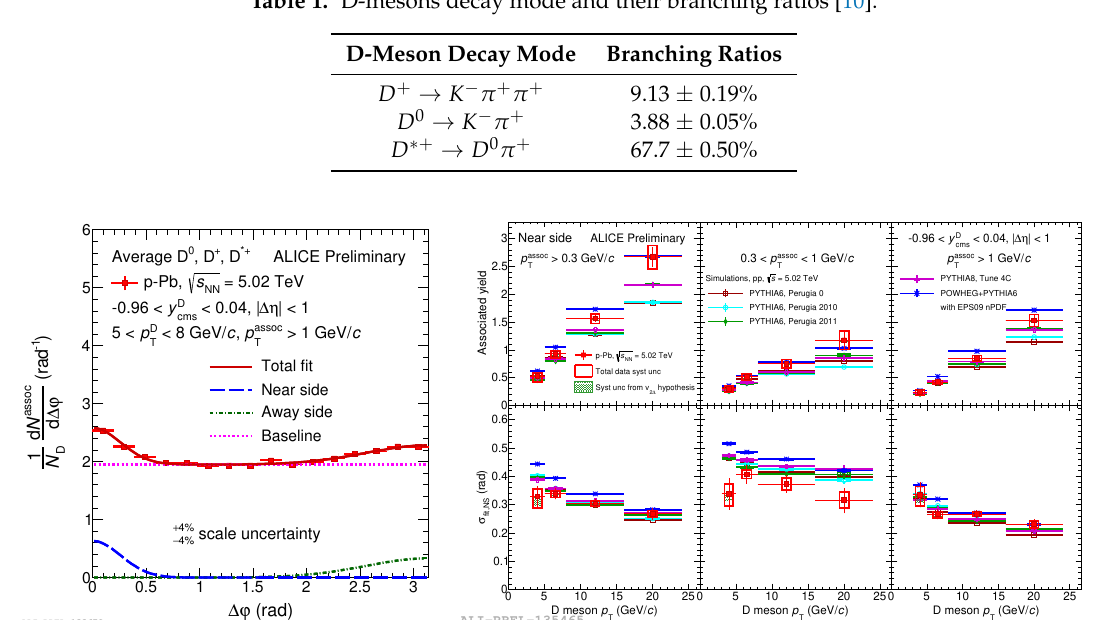
Figure 3. ( Left ) Example of reflected correlation distribution fitted with a double Gaussian and a constant baseline and ( Right ) comparison of NS yield and Gaussian width ( σ NS ) with the MC